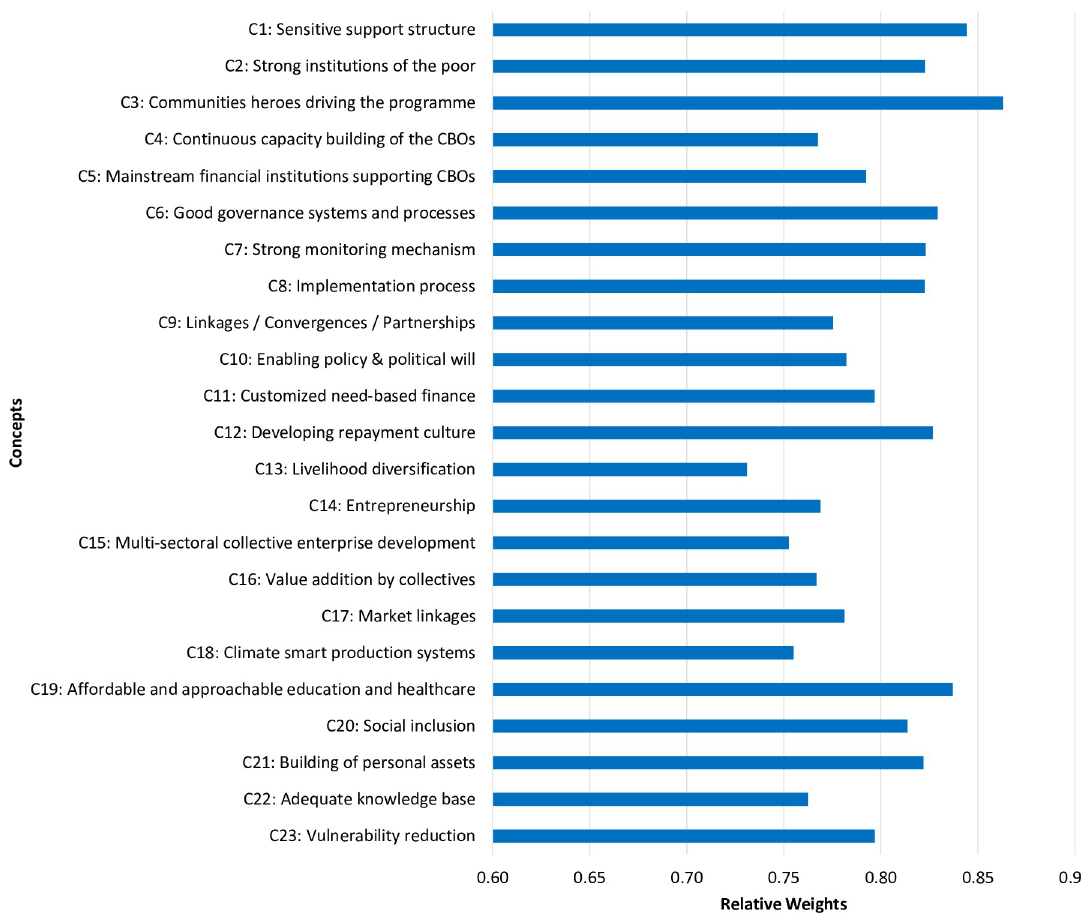
Fig 1. The relative importance of the concepts as perceived by the